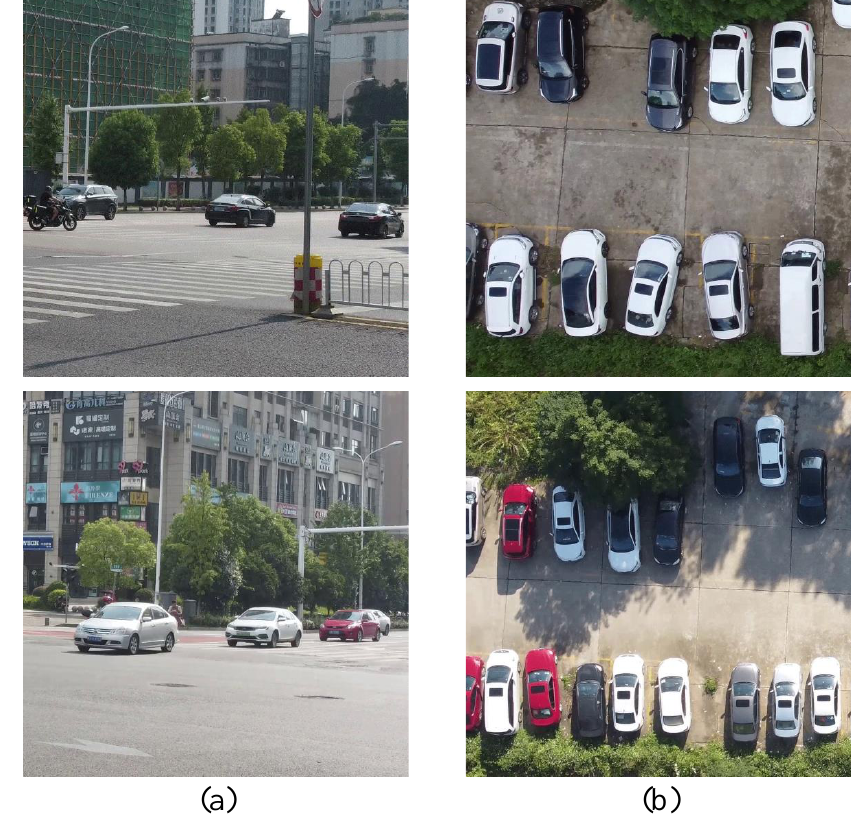
Figure 1. ( a ) Images captured on the ground. ( b ) Remote sensing images. The number of objects in remote sensing images is greater than that in images captured on the